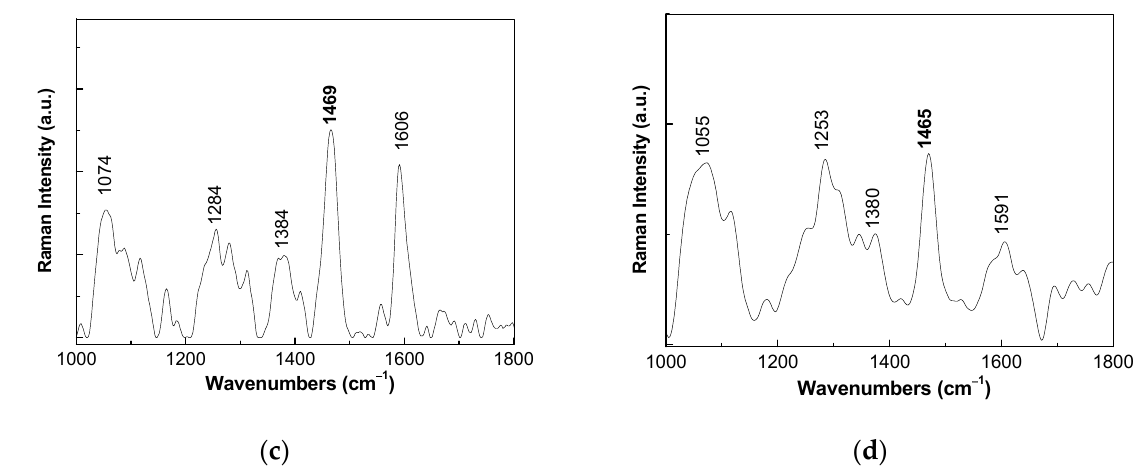
Figure 3. The Raman spectra of PDITC ( a ), protein G ( b ), anti-EGFR ( c ), and EGFR ( d ). In this context, we note that: (i) down-shift of the Raman line from 1490 cm − 1 (Figure 2b,c) to 1485 cm − 1 (Figure 2e) can be explained, taking into account both the presence of Raman line of protein G at 1456 cm − 1 (Figure 3b) and its chemical interaction with the SPCE-RGO/PDPA-PDITC; and (ii) new Raman line of EGFR at 1465 cm − 1 ,